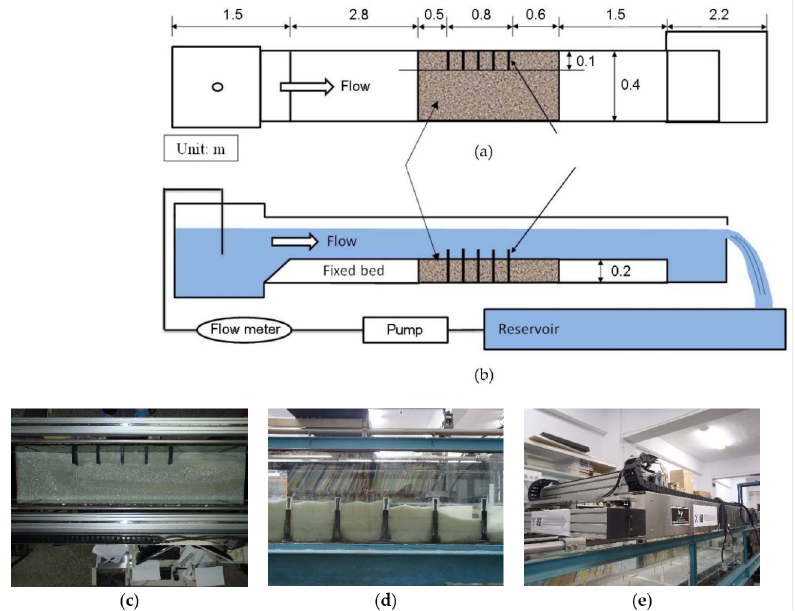
Figure 6. Overview of the multiple spur dike experimental channel: ( a ) top view, ( b ) side view, ( c ) top view of the morphological changes after conducting the experiment, ( d ) side view of the morphological changes after conducting the experiment, and ( e ) laser rangefinder system.